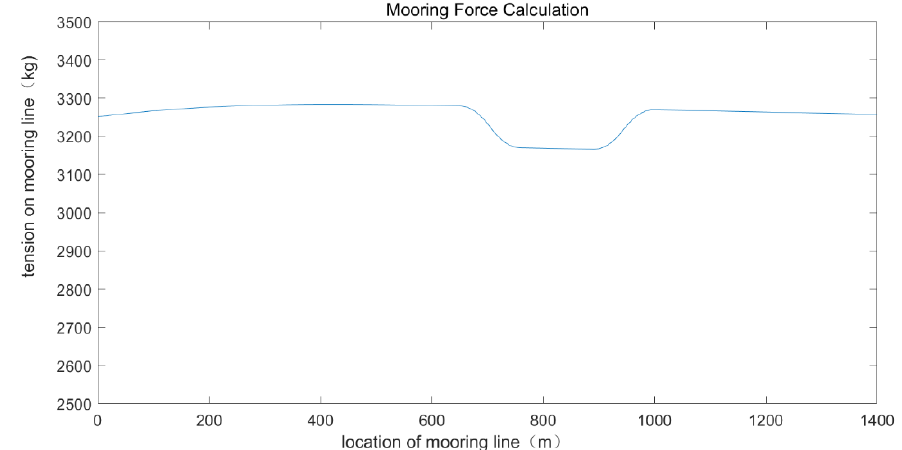
Figure 18. Mooring force property of the buoy under the wind speed of 70 m/s and current velocity of